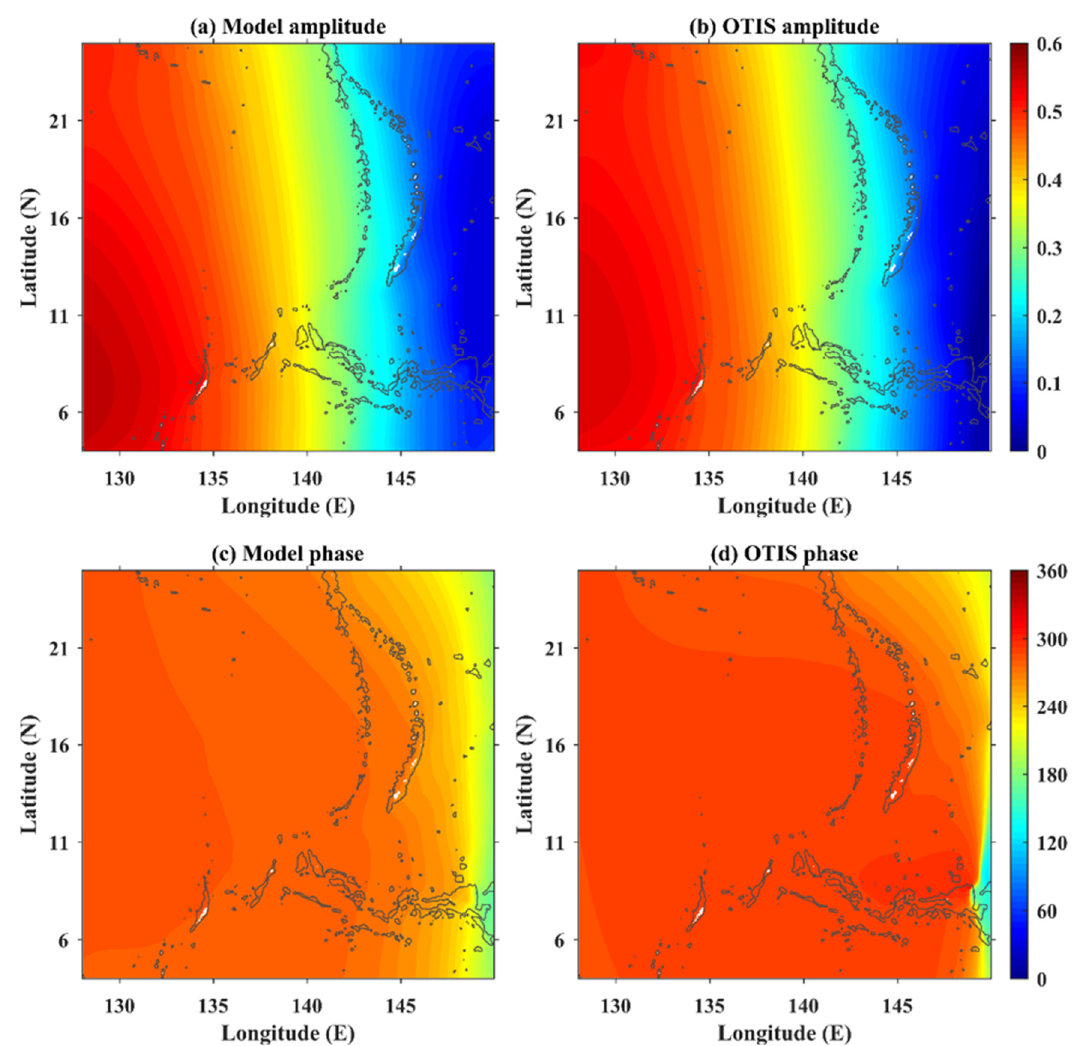
Figure 2. Model simulated ( a ) and OTIS ( b ) M 2 barotropic tide amplitude (m) and Model simulated ( c ) and OTIS ( d ) M 2 barotropic tide phase (degree). Gray contours represent the 2000-m isobaths.